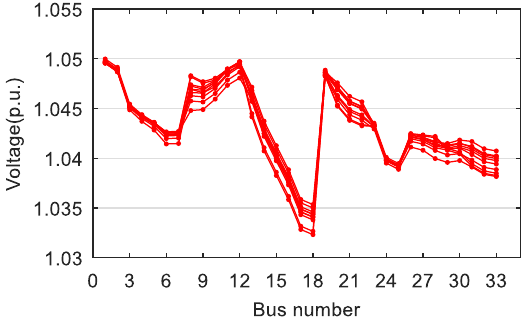
Appl. Sci. 2020 , 10 , x FOR PEER REVIEW Figure 9. Voltage profiles at hour 17 in Case 4. Figure 9. Voltage profiles at hour 17 in Case 4. Figure 9. Voltage profiles at hour 17 in Case 4.